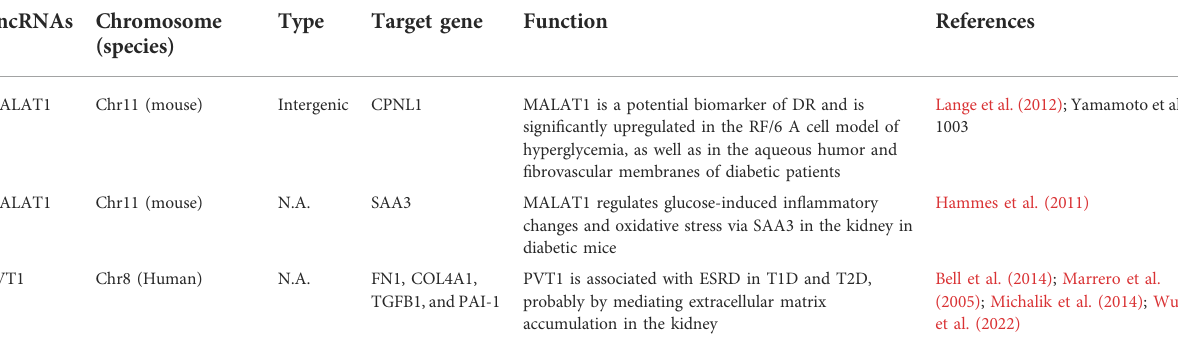
TABLE 2 LncRNAs are involved in the occurrence and development of diabetic complications. Adapted with permission from (Feng et al., 2017). Copyright 2016, Biochemistry and Cell Biology. LncRNAs Chromosome